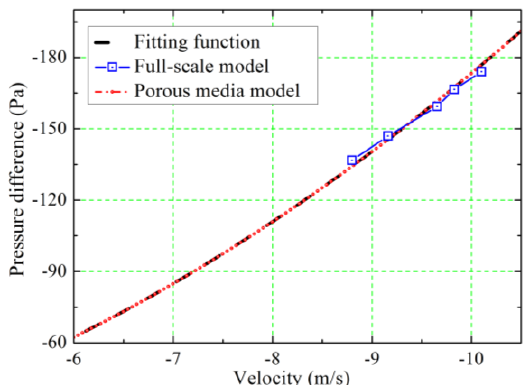
Figure 10. Comparison of the curve-fitting function, full-scale PSD gap model and porous media model.